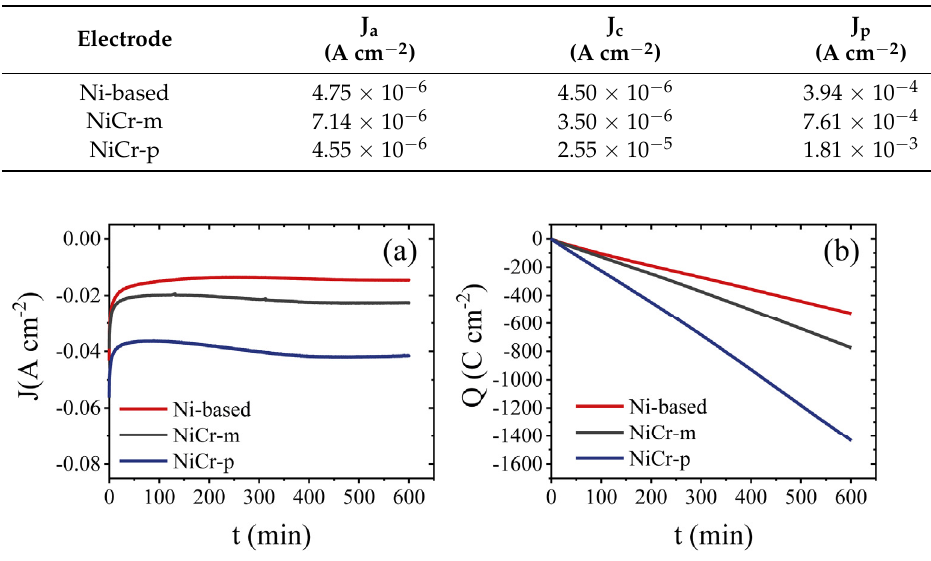
Figure 9. Potentiostatic test at − 1.5 V vs. SCE in 1.5 M NaOH; ( a ) I-t curves and ( b ) Q-t curves.